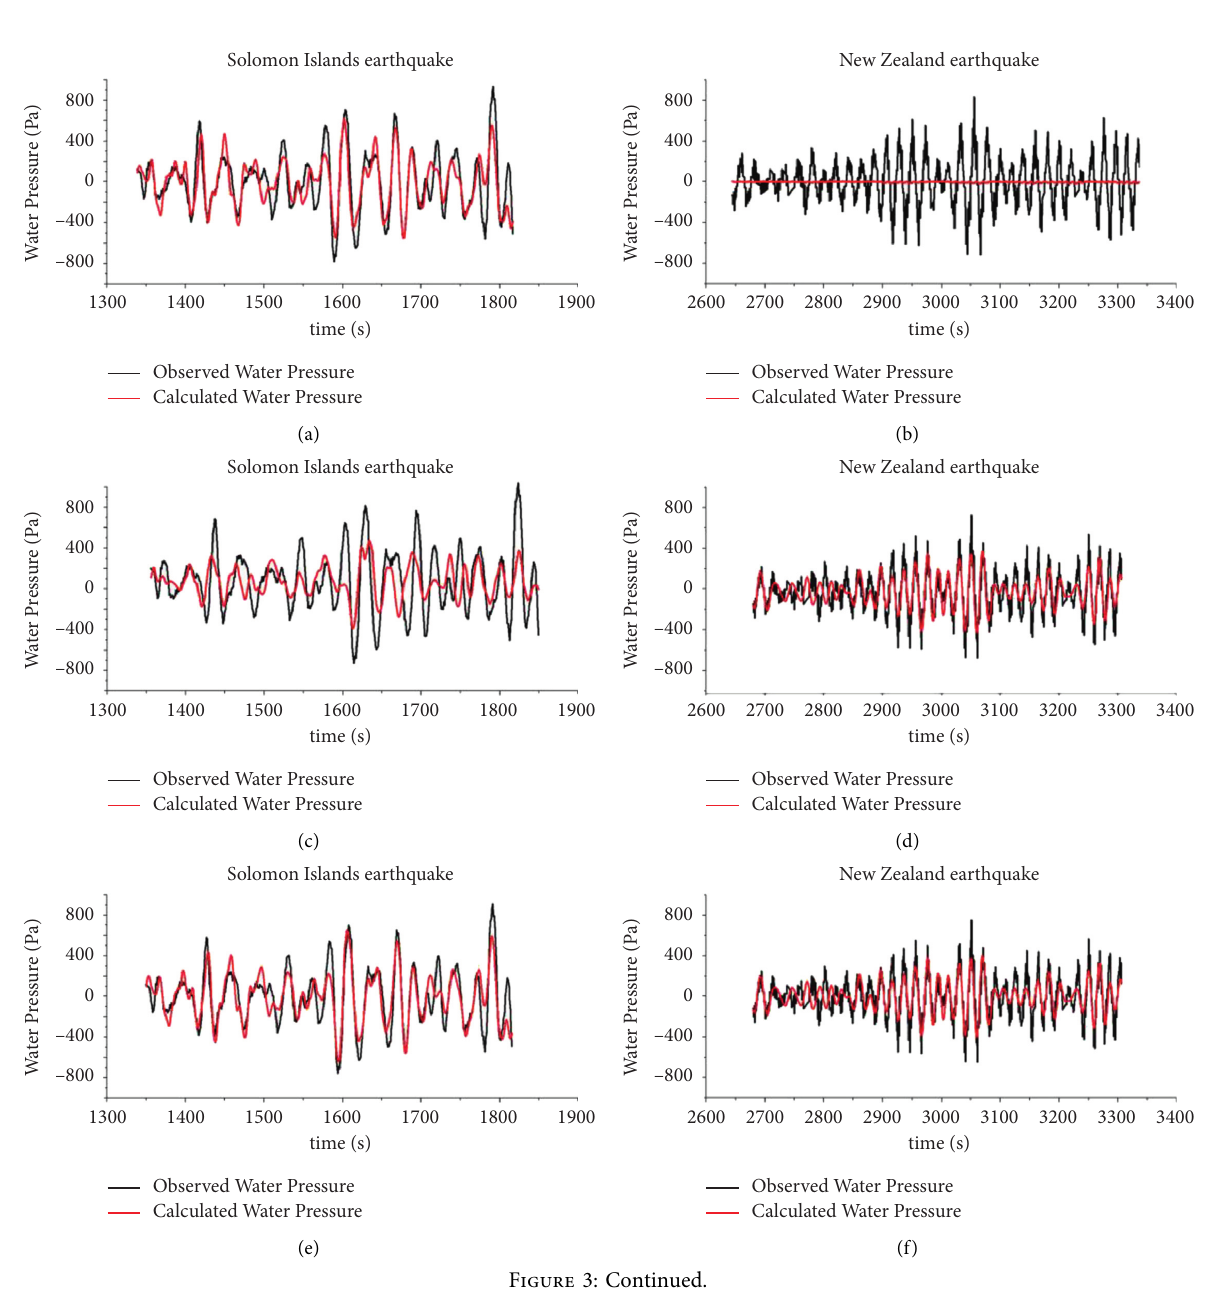
Table 1: Well-aquifer system parameters by M